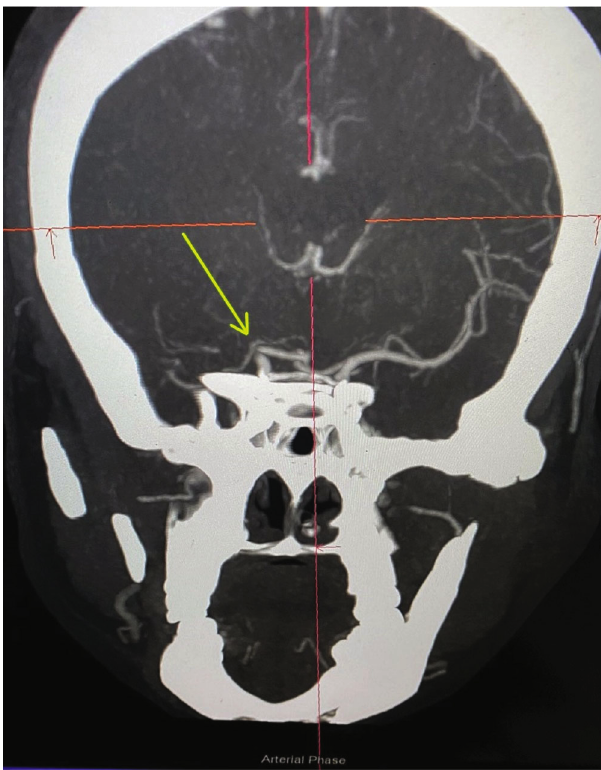
Figure 2: Cerebral CT angiography showing non-opaci fi cation of distal ICA and MCA